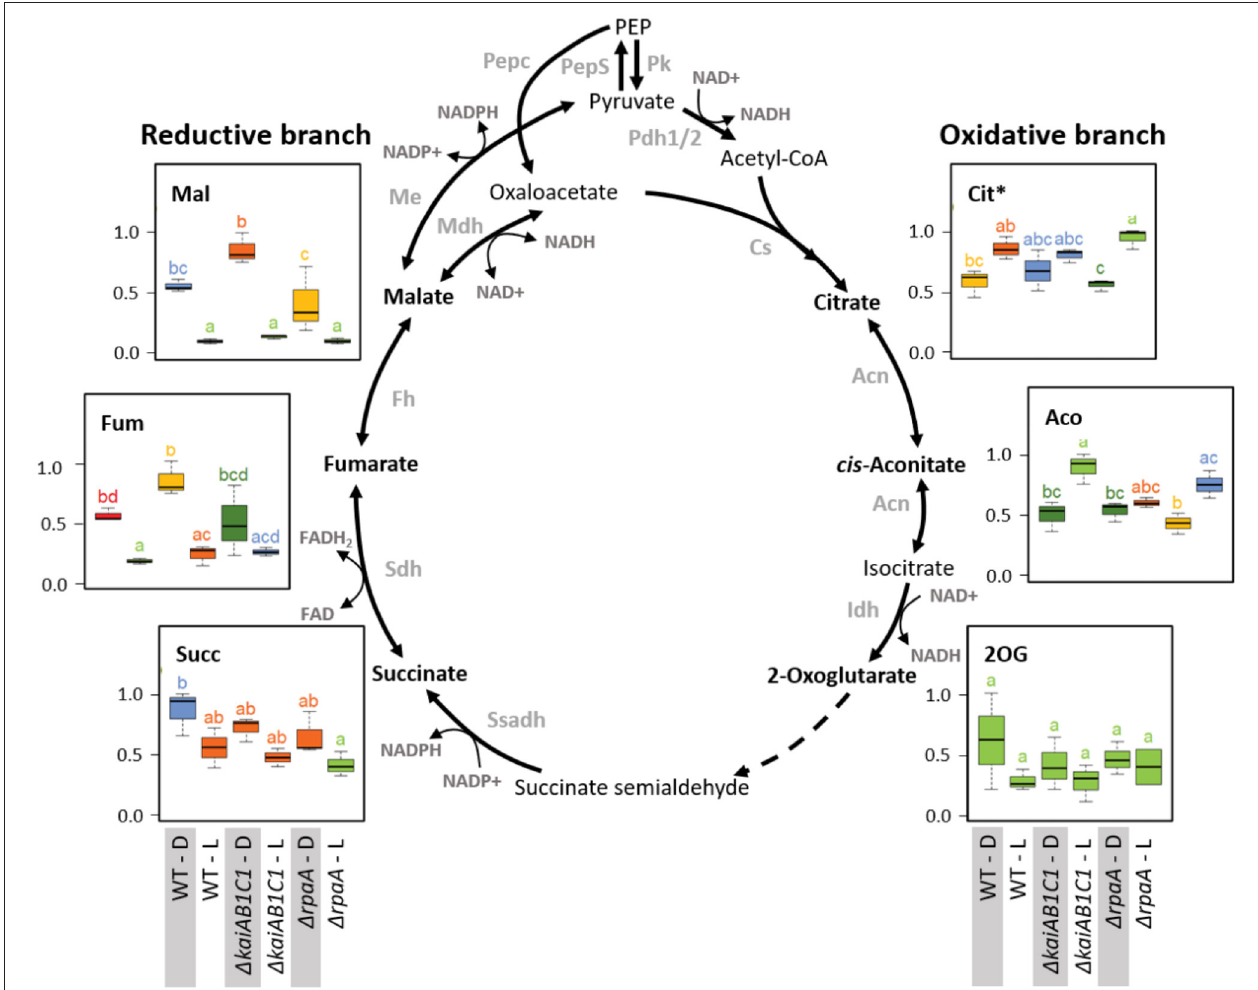
FIGURE 10 | Tricarboxylic acid pathways. Box plots showing the maximum normalized relative changes in the metabolite concentrations and Tukey test results ( P < 0.05, n = 3). Metabolite levels that significantly differ are indicated by lowercase letters and color coding. Note the inverse accumulation of metabolites from the oxidative and reductive branches of the TCA pathways. The concentrations of the intermediates of the TCA reactions were largely unchanged in the 1 kaiAB1C1 and 1 rpaA cells. Dashed arrows indicate multiple reaction steps. Relevant enzymes and complexes included (gray) phosphoenolpyruvate synthase (PepS), pyruvate kinase (Pk), pyruvate dehydrogenase (Pdh), phosphoenolpyruvate carboxylase (Pepc), citrate synthase (Cs), aconitase (Acn), isocitrate dehydrogenase (Idh), succinate semialdehyde dehydrogenase (Ssadh), succinate dehydrogenase (Sdh), fumarase (Fh), malate dehydrogenase (Mdh), and malic enzyme (Me). *Citrate and